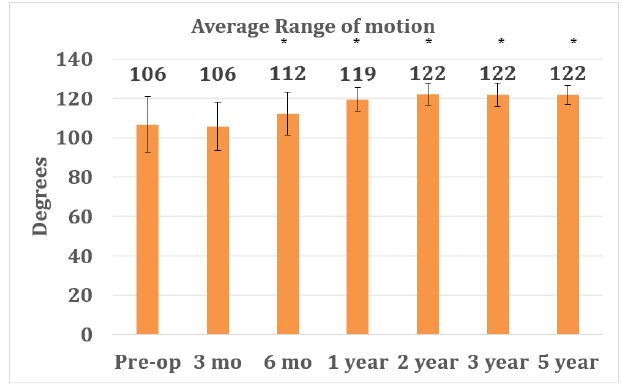
Figure 3. Average range of motion at pre-operative and follow-up time points after CCR-TKA surgery. The graph reports averages +/ − SD. Asterisks (*) indicate statistical significance compared with the pre-op control, as determined by Student’s t -test ( p < 0.05).